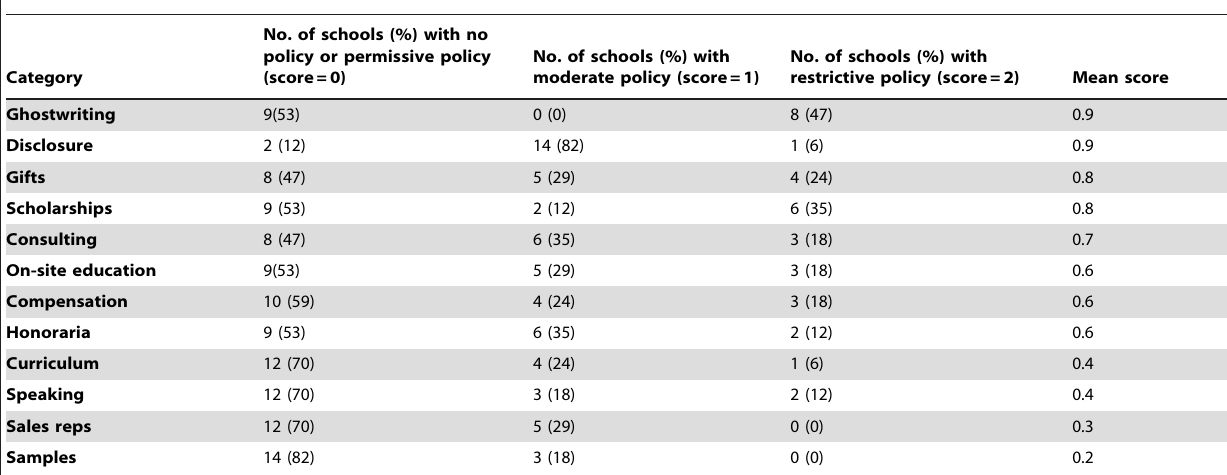
Table 3. Number (%) of Canadian medical schools with policies in each category and strength of